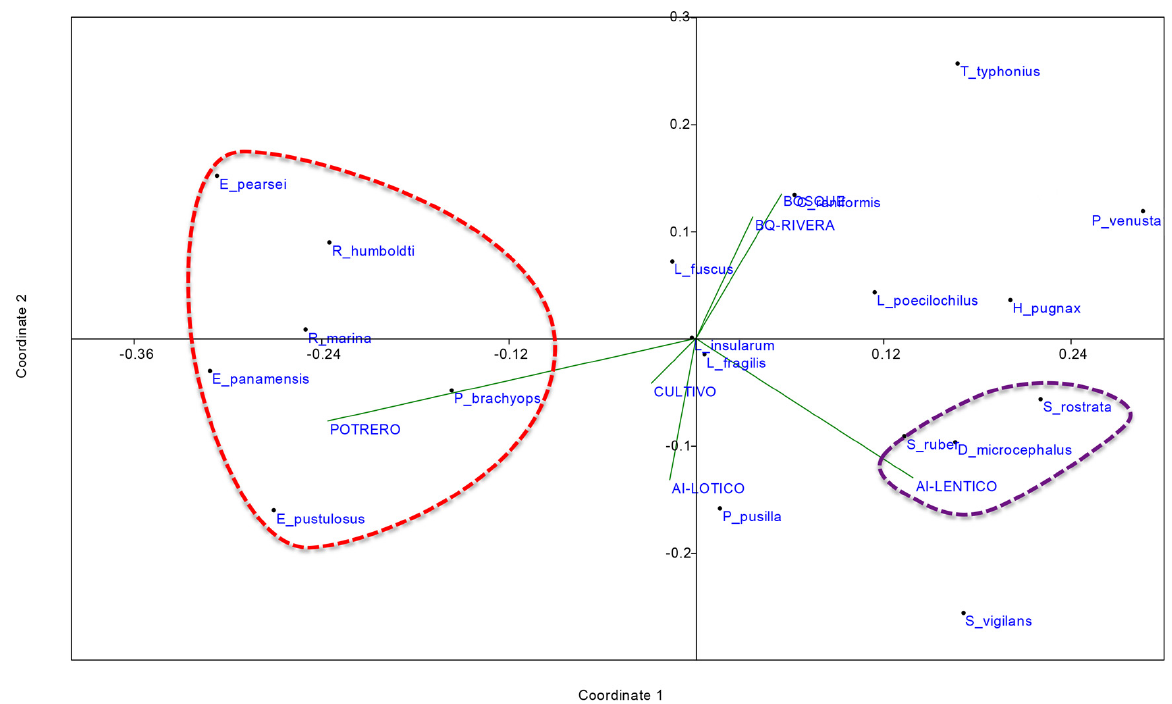
Figure 3. Trophic guilds of anurans in areas of tropical dry forest of the Colombian Carribbean, based on diet and habitat use. The areas enclosed in dotted lines represent the probable trophic